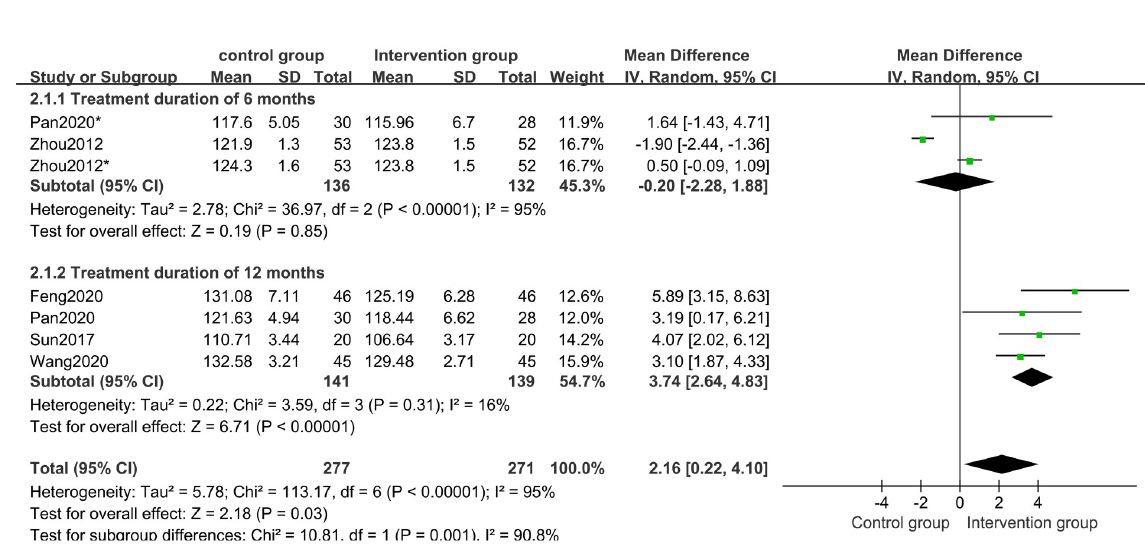
Fig 4. Subgroup analysis of height based on the treatment duration.